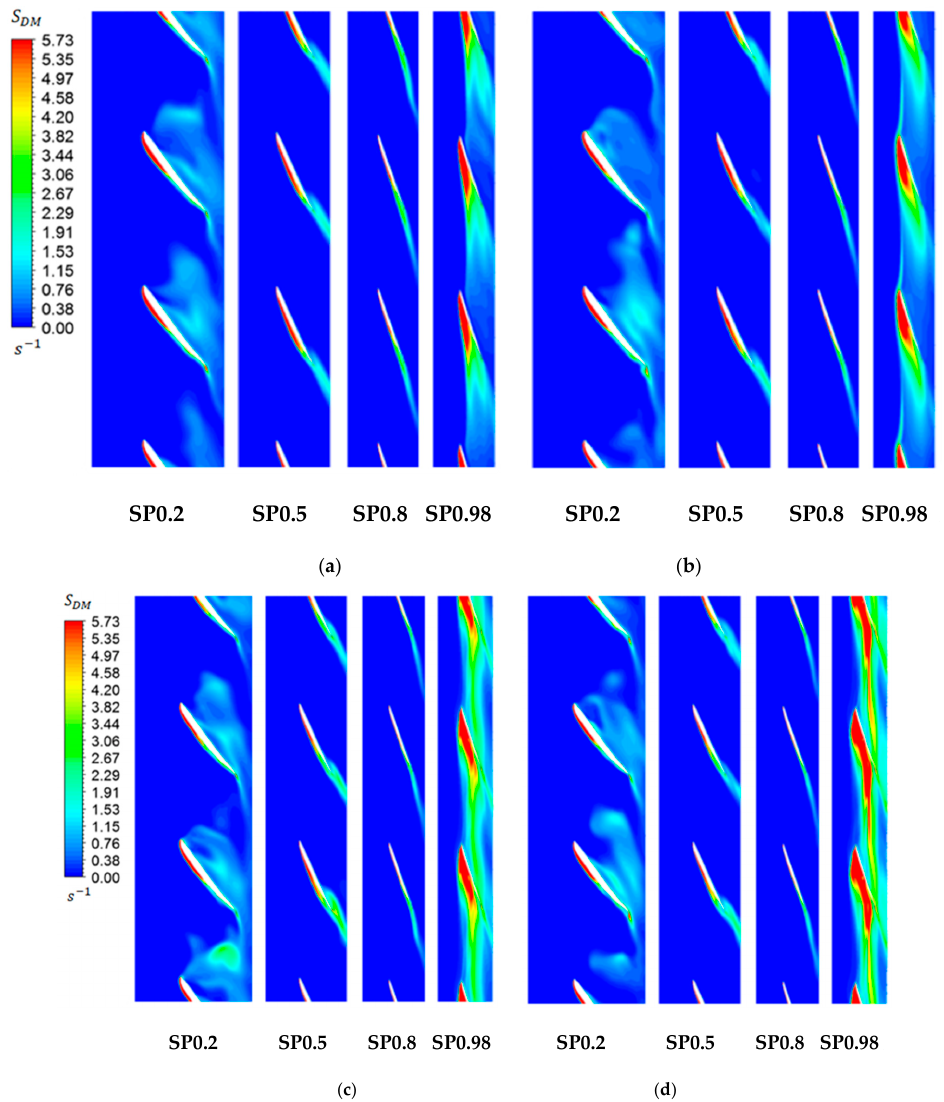
Figure 16. Distributions of S DM (reflecting the turbulent entropy generation rate) along di ff erent spanwise surfaces of the impeller for varying tip clearance at ϕ = 0.354 (( a ) h = 0.1% span; ( b ) h = 0.3% span; ( c ) h = 0.6% span; and ( d ) h = 0.8% span)